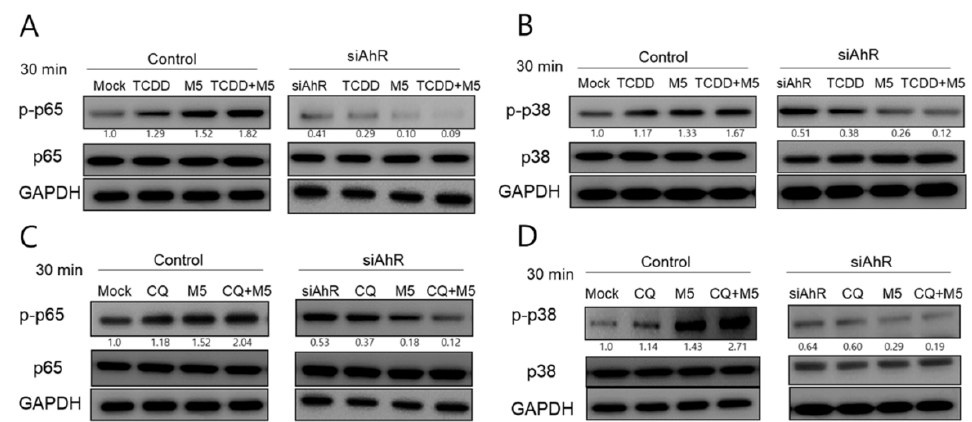
Figure 6. AhR siRNA transfection suppressed TCDD- and chloroquine-induced phosphorylation of p65NF- κ B and p38MAPK in M5-stimulated HaCaT cells. ( A–D ) HaCaT cells were stimulated by M5 for 48 h before transfection. M5-stimulated HaCaT cells were transfected with AhR siRNA. At 48 h post-transfection, p65 and p38 phosphorylation was evaluated by Western blotting after a 30-min treatment with TCDD or chloroquine. The density of phosphorylated p38MAPK and p65NF- κ B band was normalized to the corresponding loading control. Results are representative of three independent experiments. CQ, chloroquine.